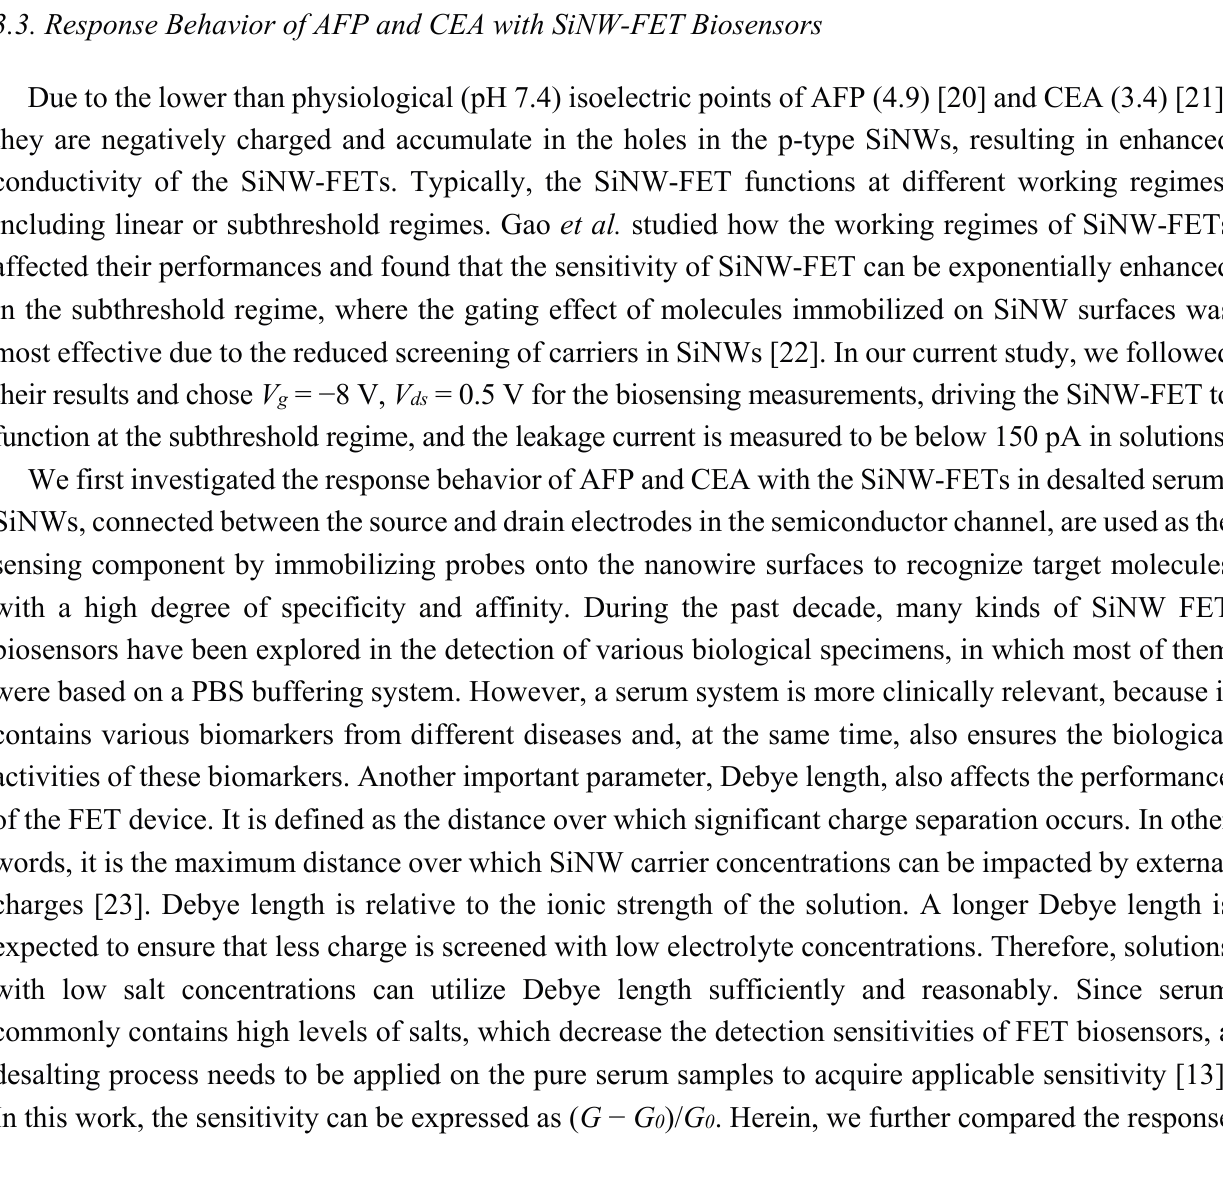
Figure 3. Typical p-type electrical characterization of fabricated SiNW-FETs. ( A ) The I ds − V ds output curve depended on the V g varying from 0 to − 10 V; ( B ) The I ds − V g transfer curve extracted at V ds = 1